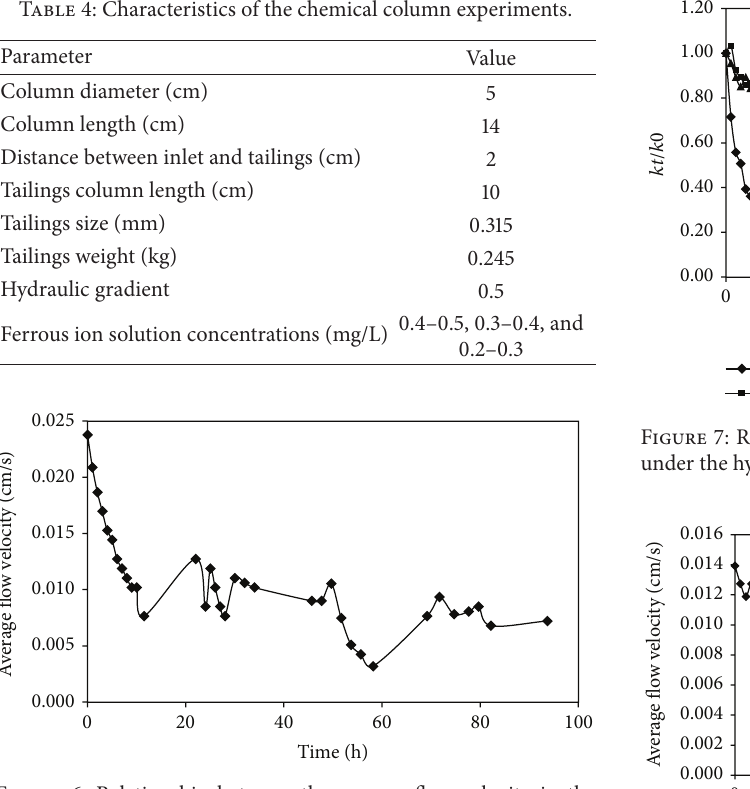
Figure 6: Relationship between the average flow velocity in the tailings column and time under the hydraulic gradient of 1.25 (experiment 1).